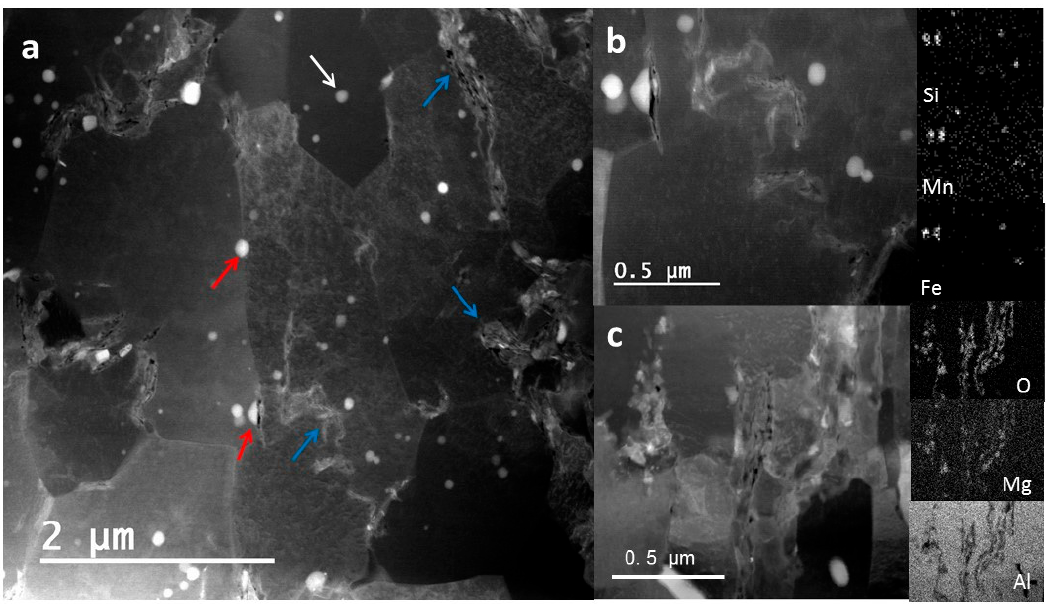
Figure 2. ( a ) STEM image of the microstructure of AA6005A profiles (white arrows show isolated precipitates within the Al matrix alloy, red arrows show isolated precipitates at the grain boundary, and blue arrows show local areas with an accumulation of irregular flakes). ( b ) STEM images corresponding to the precipitates at the white and red arrows and EDS elemental mapping analysis results on these precipitates particle. ( c ) High-amplification images of an area of accumulation of irregular flakes, and EDS elemental mapping analysis results on irregular flakes.